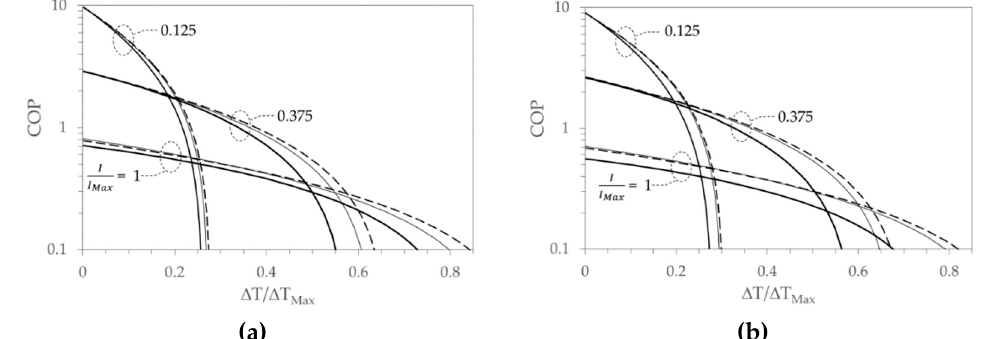
Figure 11. 𝑇 (cid:3009) = 298.15 𝐾 . Coefficient of performance against the relative temperature difference Δ𝑇/Δ𝑇 (cid:3014)(cid:3028)(cid:3051) at different relative feeding current 𝐼/𝐼 (cid:3014)(cid:3002)(cid:3025) , thick solid lines represent the performed experiment, dashed lines refer to temperature-independent thermoelectric properties, thin solid lines denote the scenario in which the Seebeck coefficient is temperature-dependent and both electrical resistivity and thermal conductivity are temperature independent: ( a ) case ( i ); ( b ) case ( ii ).